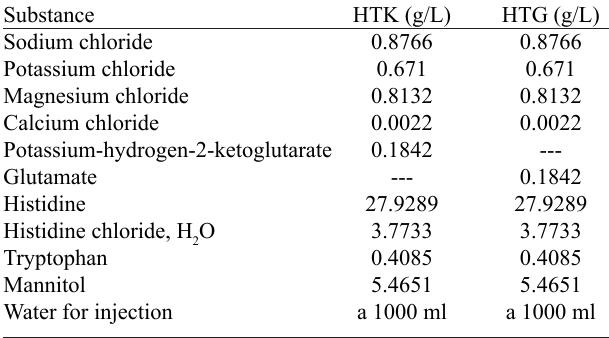
Table 1. Composition of solutions used. Substance